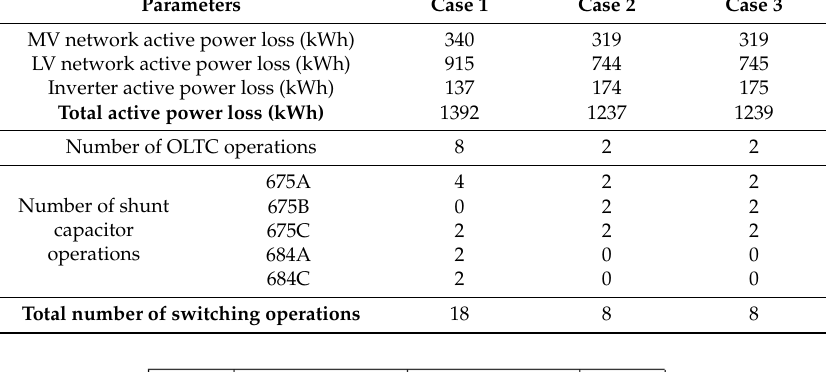
Table 5. Case study results for different VVO methods.